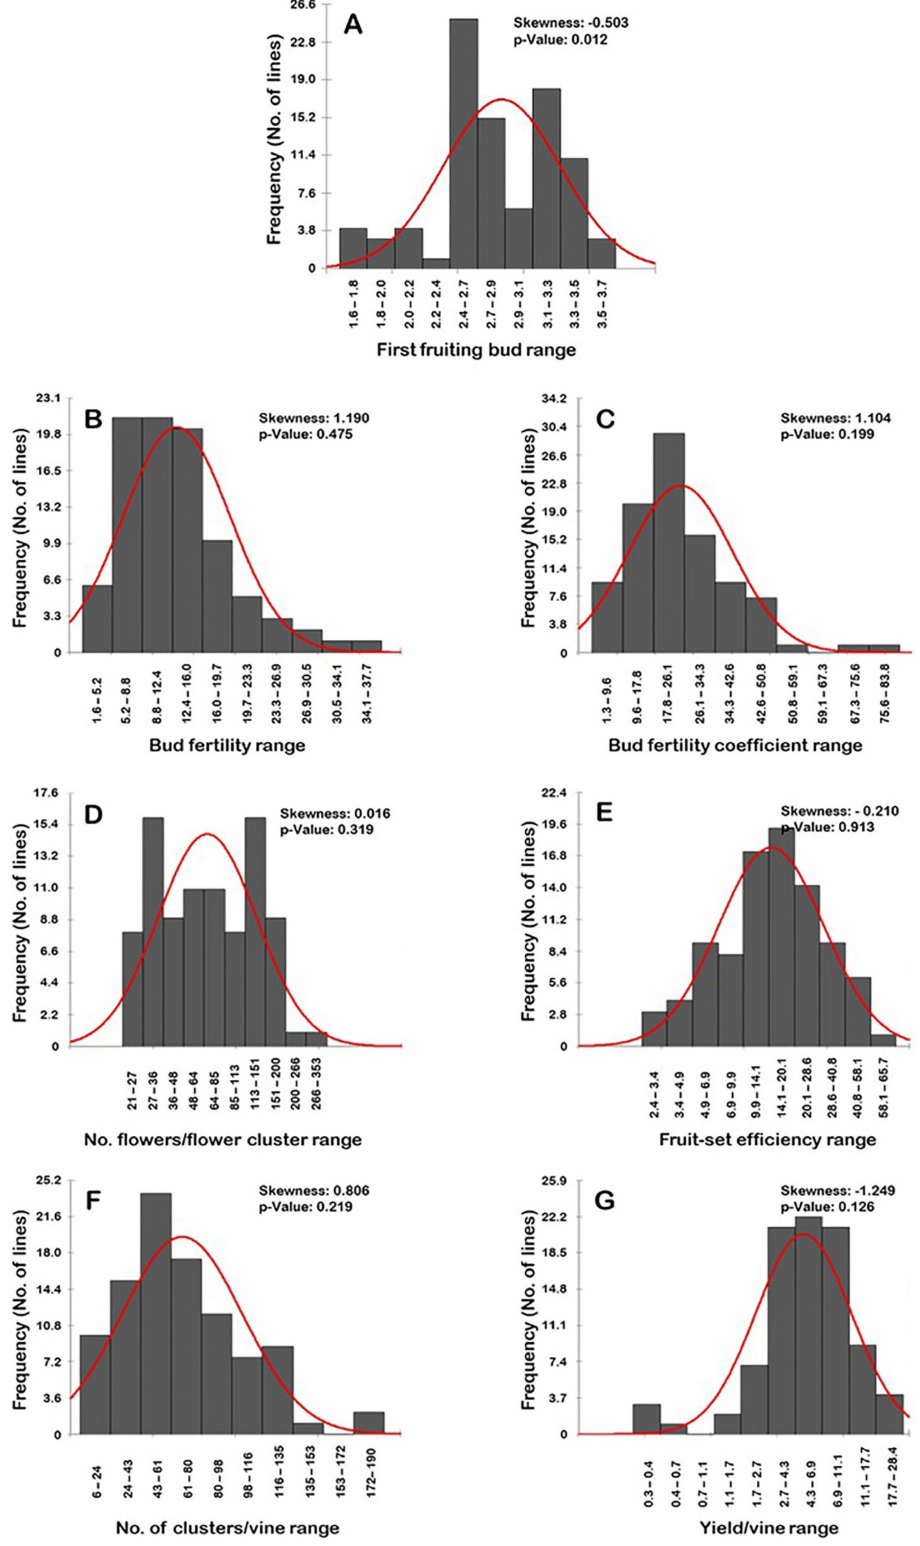
Figure 8. Frequency distribution of the fertility-related traits, first fruiting bud—FFB ( A ), bud fertility—BF ( B ), bud fertility coefficient—BFC ( C ), number of flowers/flower cluster—N.F/FC ( D ), fruit-set efficiency—FSE ( E ), number of clusters/vine—N.C/V ( F ), and yield/vine—Y/V ( G ) of the muscadine population ( n = 90). The skewness degree and p -value of the Kolmogorov–Smirnov normal distribution test are